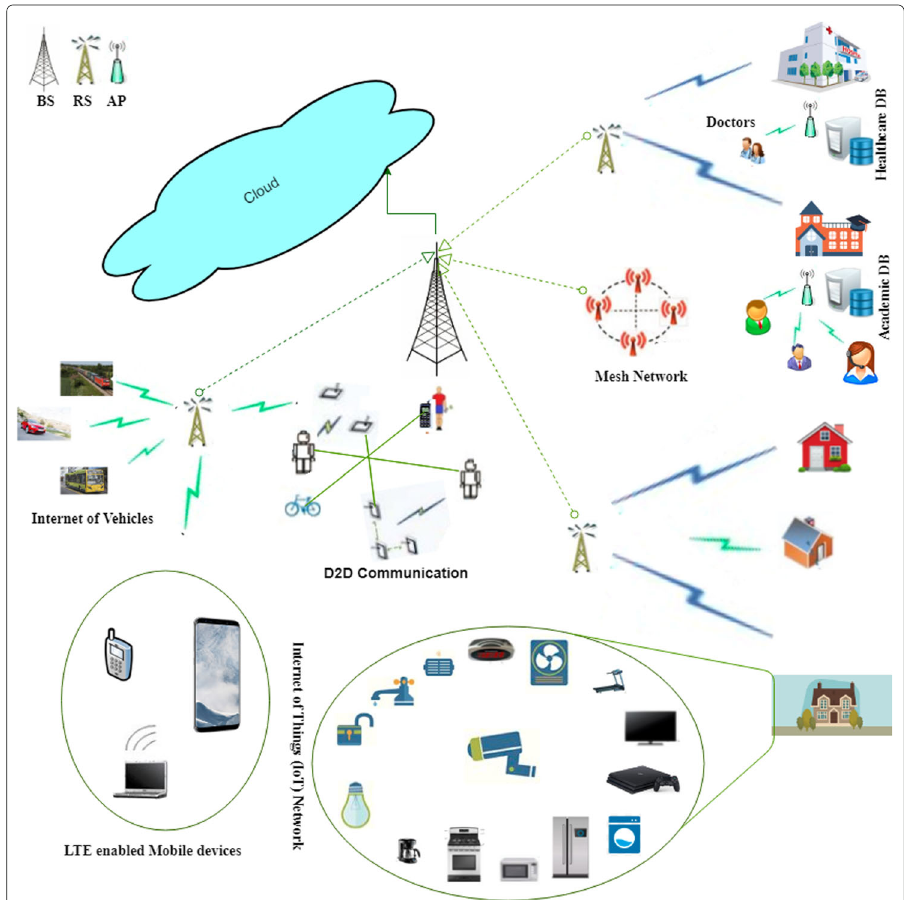
Fig. 1 Illustration of 5G and beyond wireless